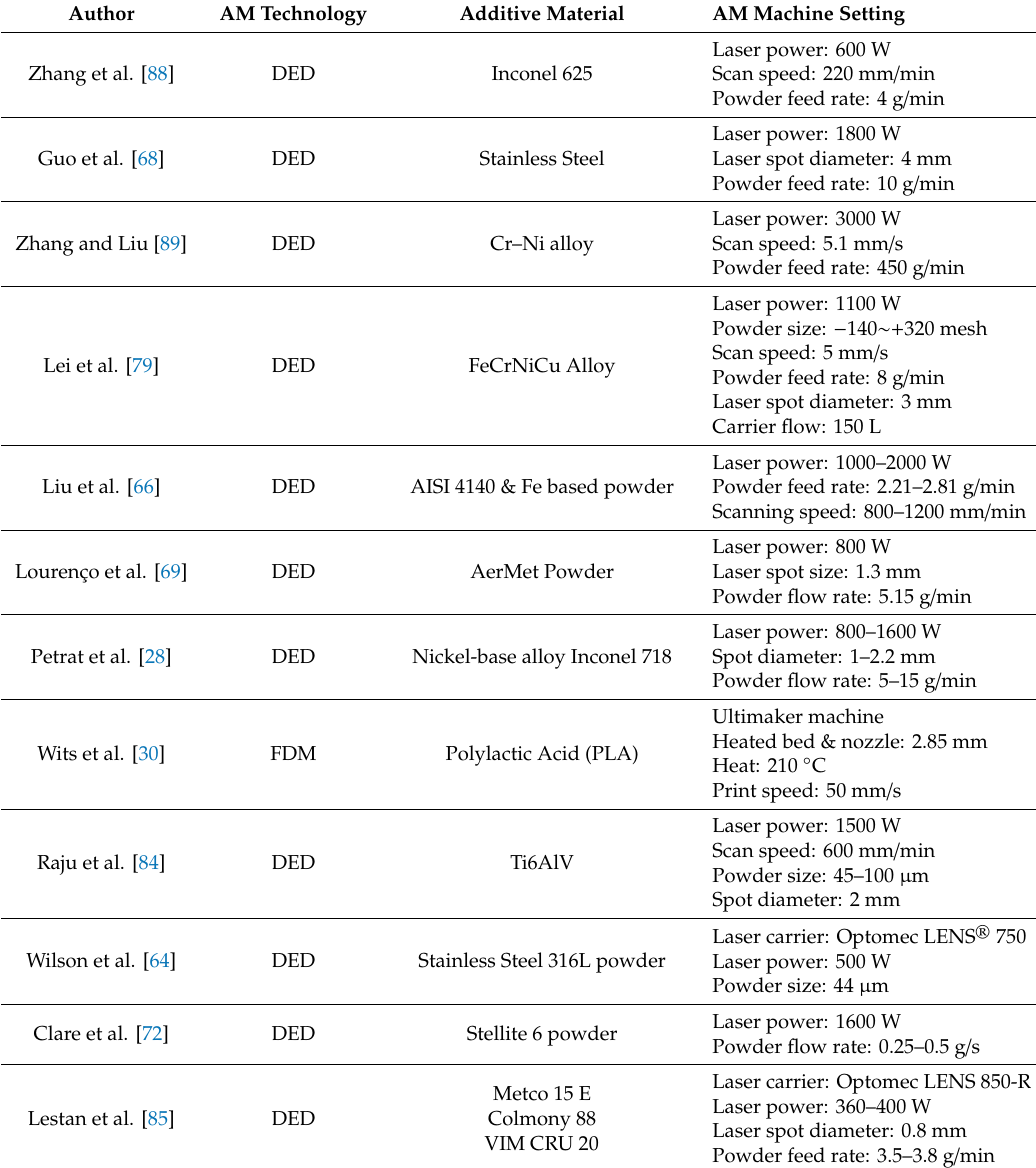
Table 7. Machine setting for di ff erent additive